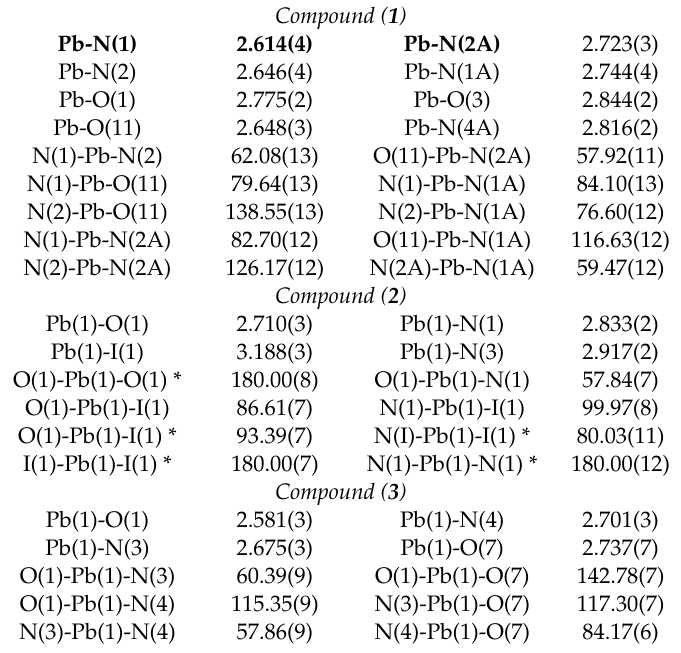
Figure 2. Molecular view of compound ( 1 ) with partial atom numbering. The unlabeled counterpart is produced through the symmetry (1 − x, − y, 1 − z). Perchlorate anion is not included for clarity. Ellipsoids are drawn at 30% probability. Table 2. Selected bond lengths (Å) and bond angles ( ◦